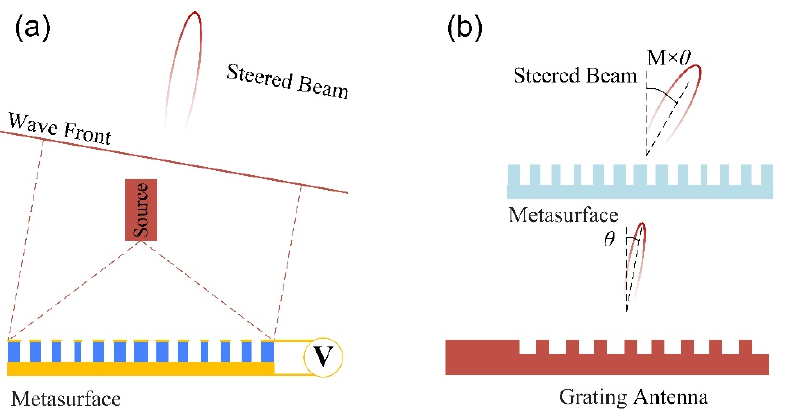
Figure 6. The schematic diagram of the meta-OPA: ( a ) normal meta-OPA; ( b ) meta-assisted PIC-